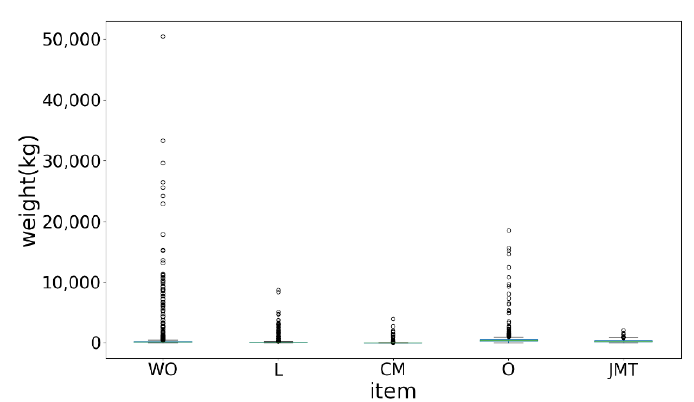
Figure 2. Boxplot of sales volumes of five items (WelshOnion (WO), Lettuce (L), ChineseMallow (CM), Onion (O), and JujubeMiniTomato (JMT)).